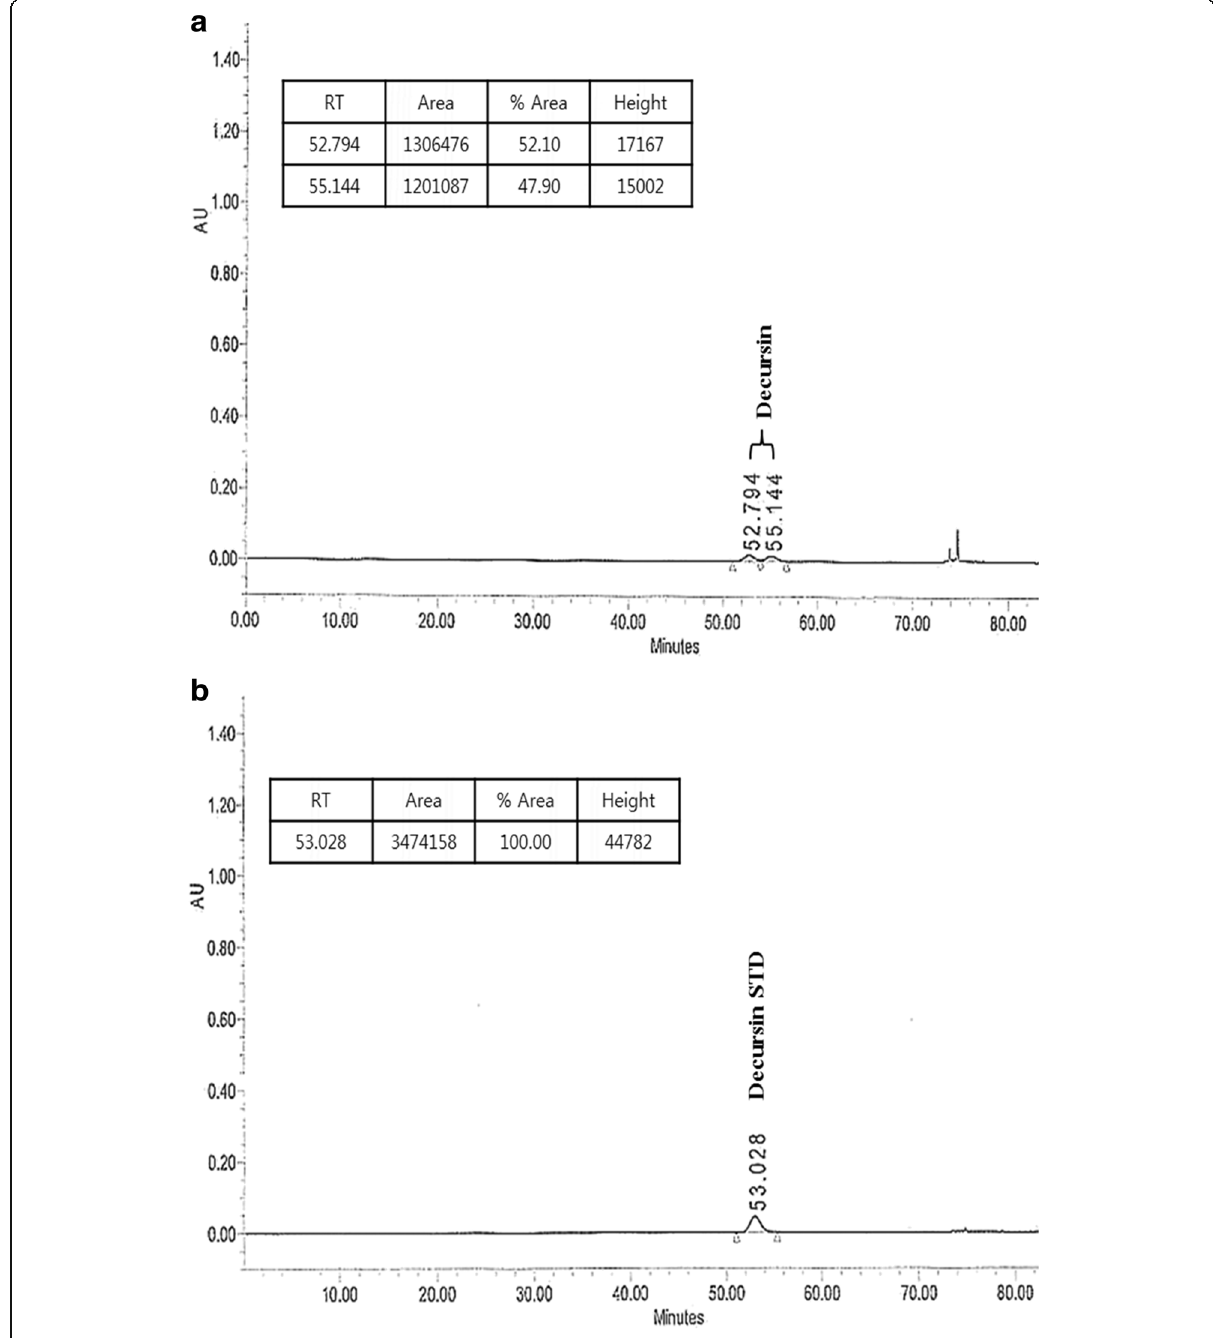
Fig. 10 LC-MS chromatogram. a Identification of decursin in Jawoongo. b Mass spectrum peak at 53.028